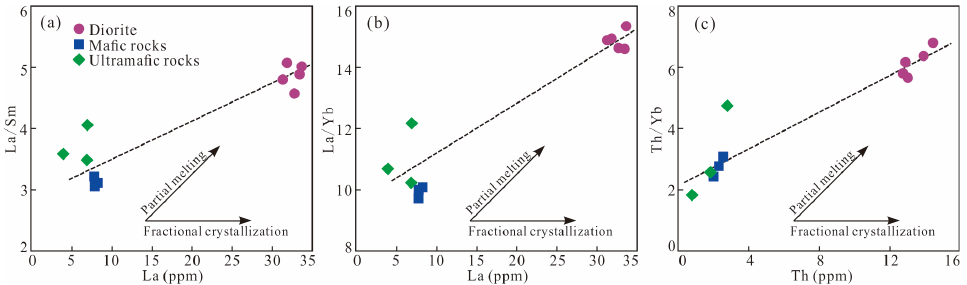
Figure 11. Diagrams of ( a ) (Th/Yb) PM versus (Nb/Th) PM (modified after [98]) and ( b ) (La/Nb) PM versus (Th/Ta) PM (modified after [99]) of the mafic–ultramafic rocks, showing crustal contamination. The Th, Yb, Nb, La and Ta contents of the primitive mantle are cited from [50].